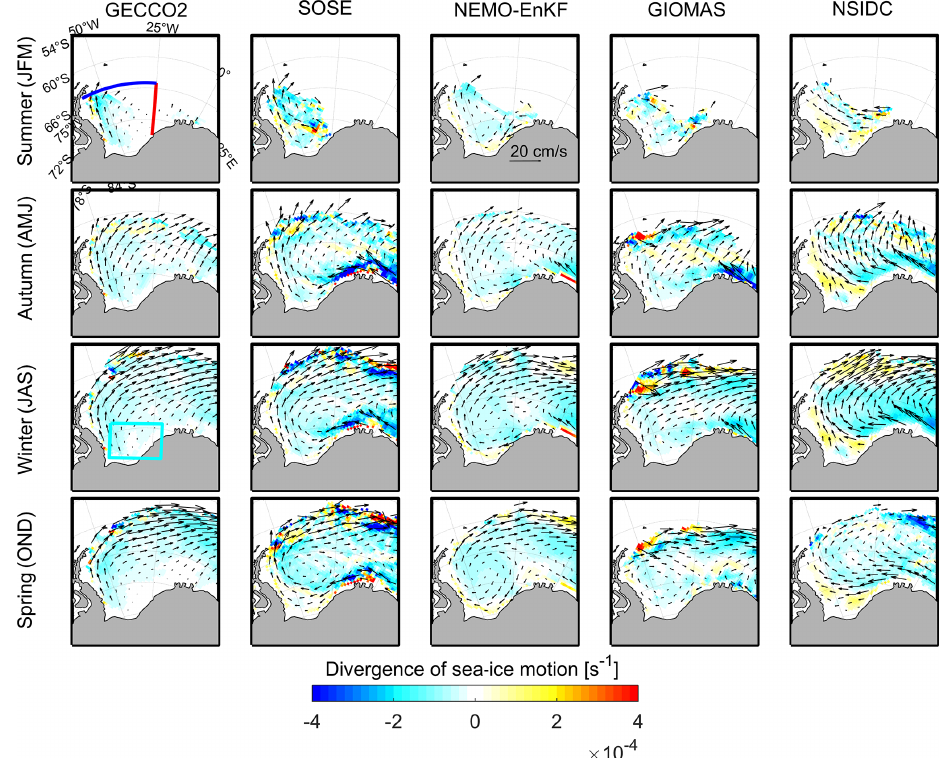
Figure 9. Same as Fig. 9 but for the divergence of sea-ice